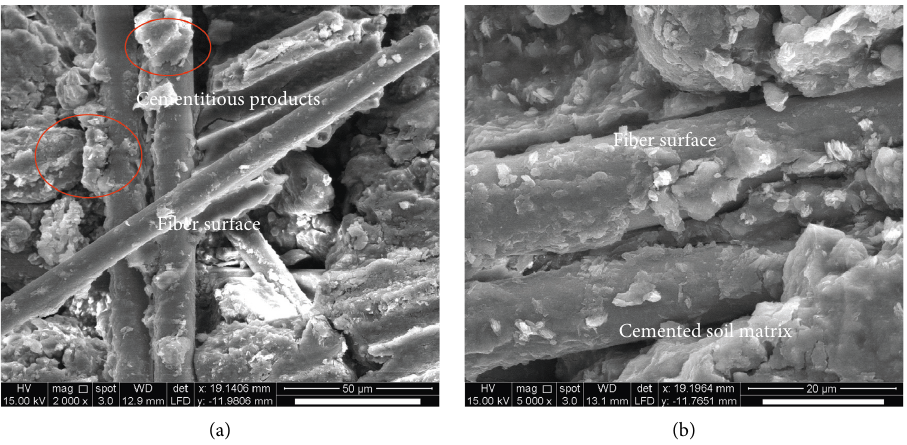
Figure 20: SEM images of the basalt fiber surface inside cement-fly ash-stabilized soil. (a) 2000x. (b)